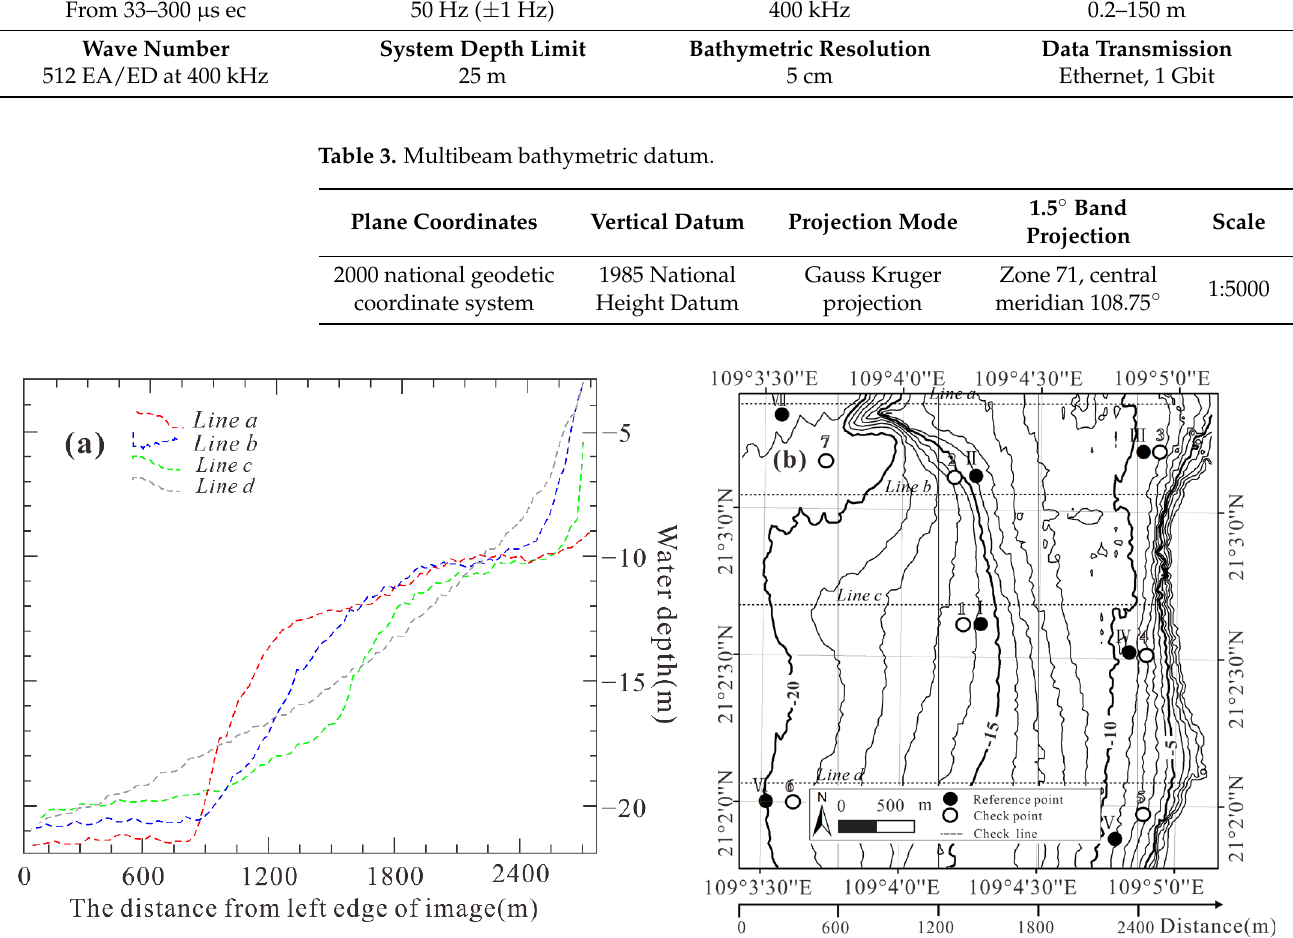
Figure 4. The transects ( a ) of 4 check lines, water depth data ( b ) measured by RESON SeaBat 7125 multibeam sounding system, the seven reference points, the, and the four check lines in the test field.